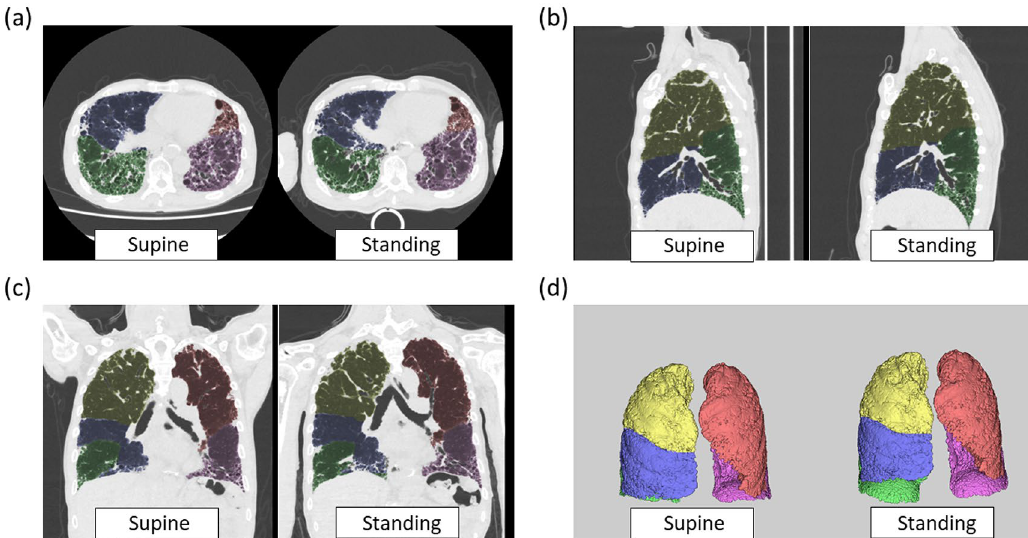
Figure 2. Representative lung and lobe volume measurements in a 71-year-old male patient with IPF. Axial images ( a ), sagittal images ( b ), coronal images ( c ), and volume rendering lung/lobe images ( d ) acquired in the supine and standing positions. Yellow indicates the right upper lobe, blue is the right middle lobe, green is the right lower lobe, pink is the left upper lobe, and purple is the left lower lobe. IPF idiopathic pulmonary